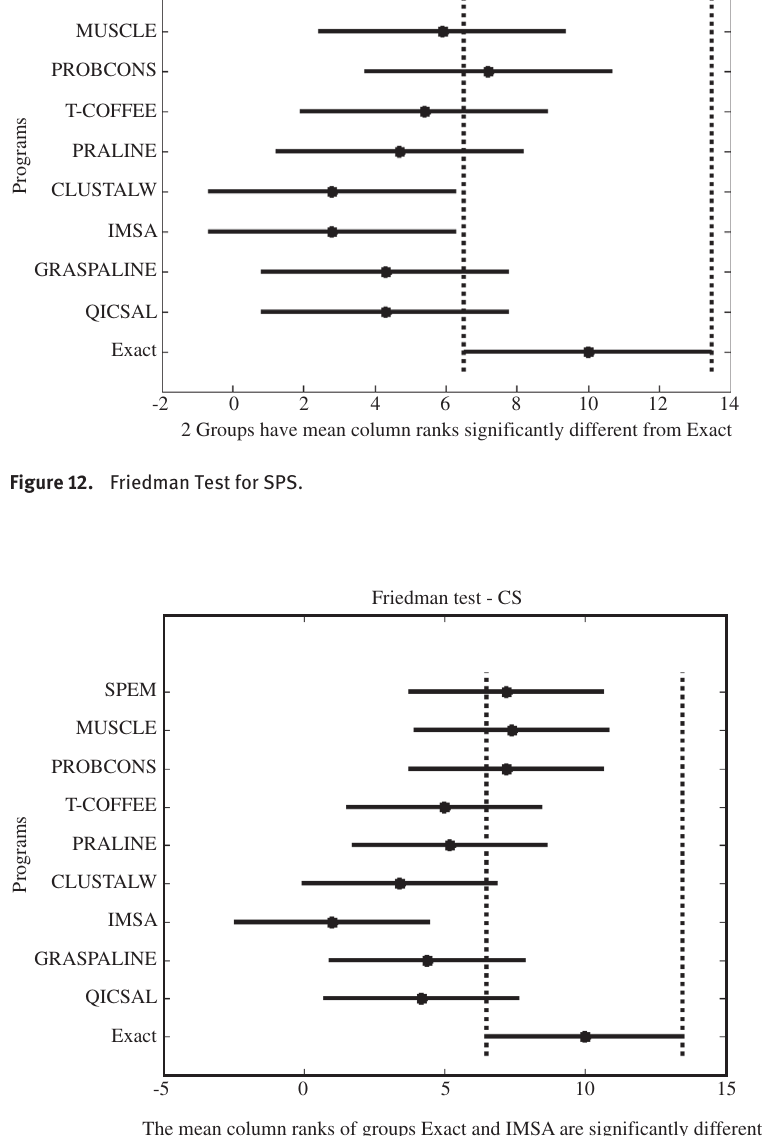
Figure 13. Friedman Test for